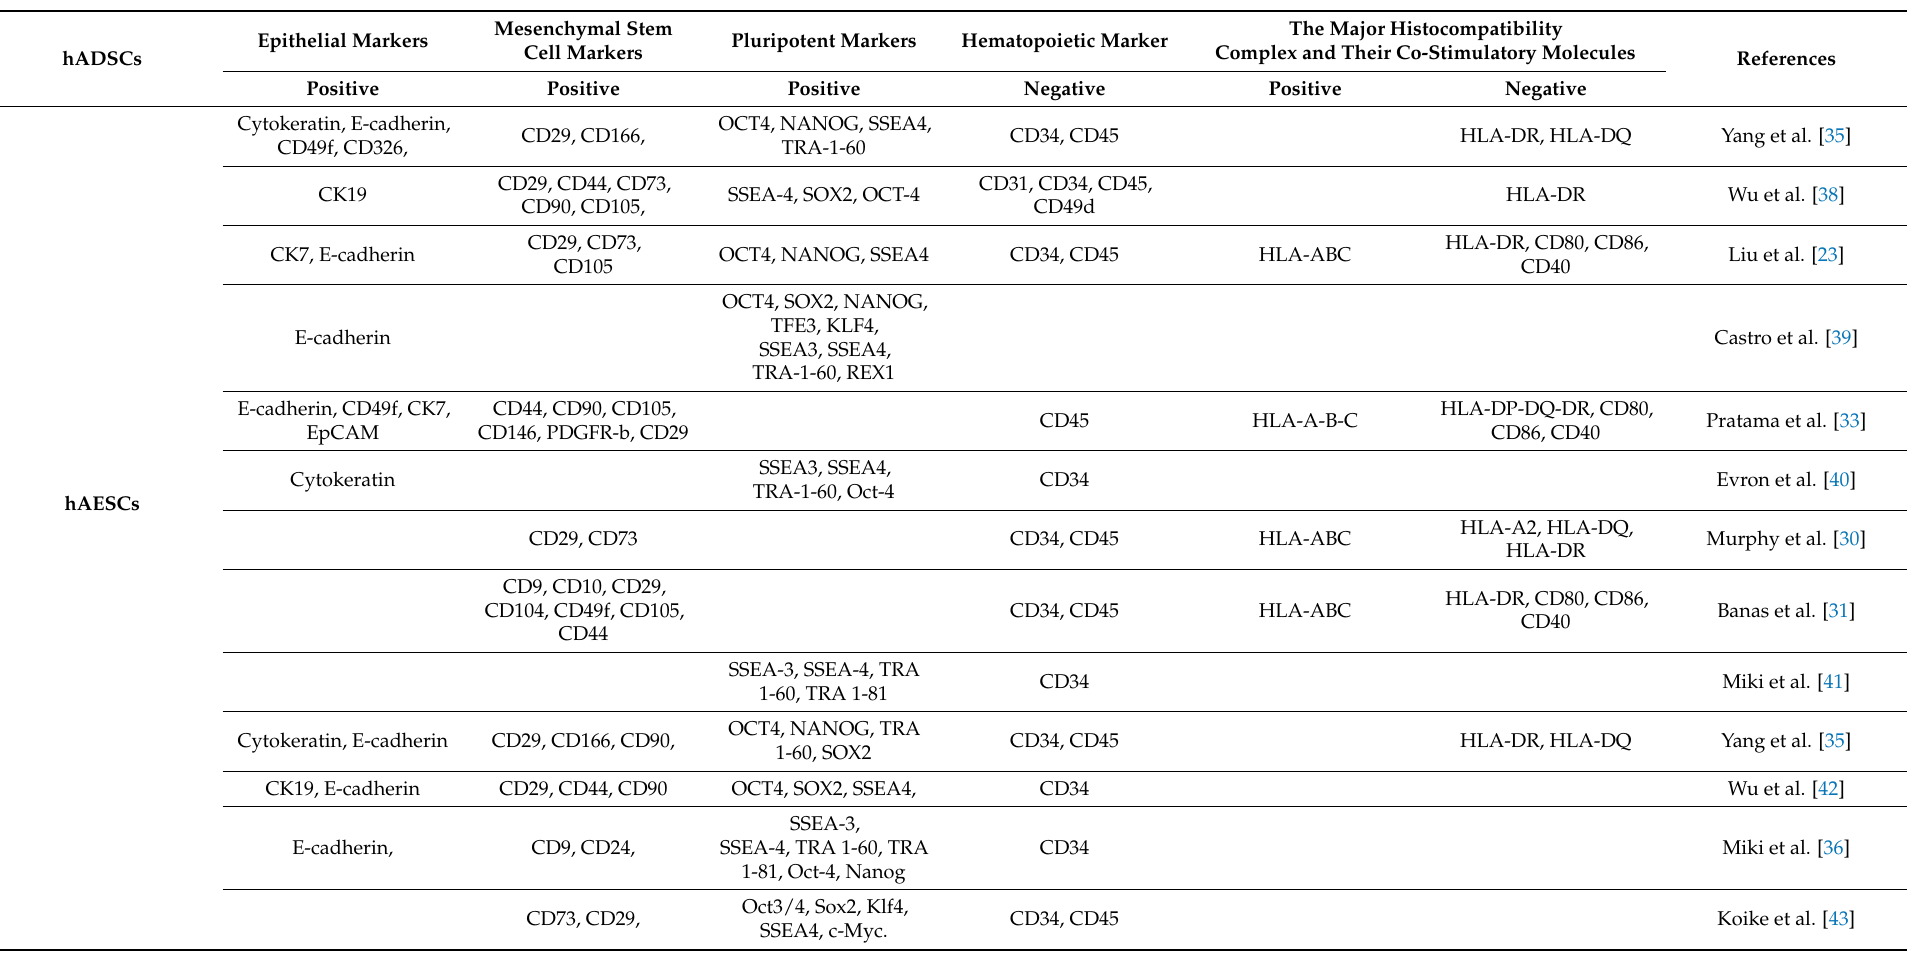
Table 1. Expression of markers of human amniotic mesenchymal stem cells and amniotic epithelial stem